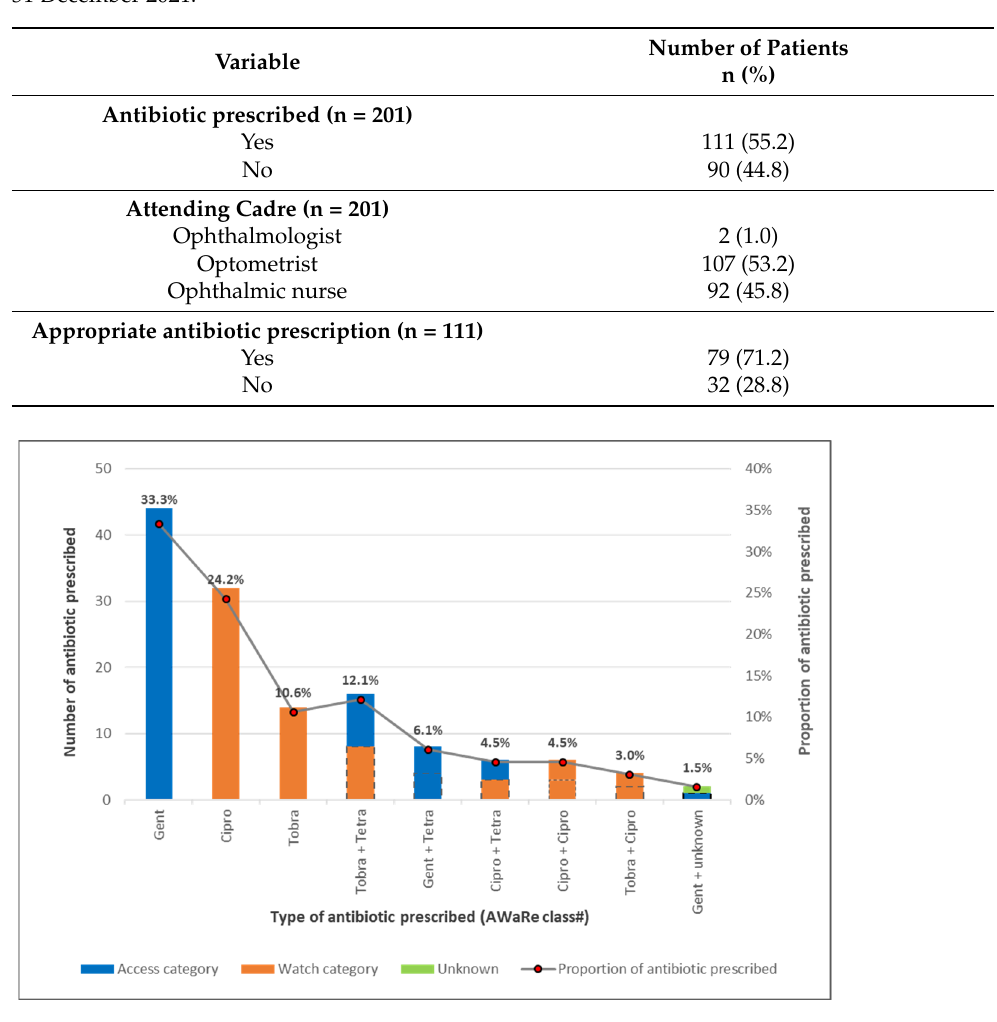
Figure 1. Antibiotic prescription pattern per WHO Access, Watch, Reserve (AWaRe) classification among patients presenting with acute conjunctivitis at a specialist eye hospital in Ghana from 1 January to 31 December